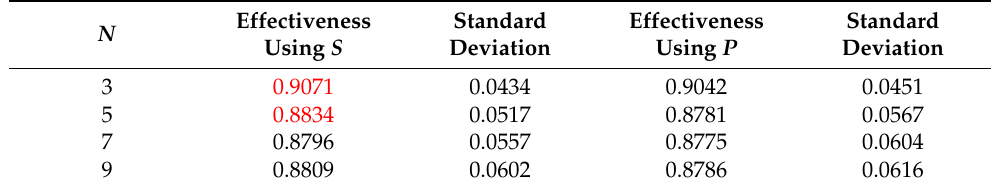
Table 6 reproduces the results of Table 5 but with a focus on the number of criteria. A significant difference is marked in red. Table 6. Comparison of effectiveness using the reflexive relation S and using the asymmetric relation P in the context of the number of criteria.